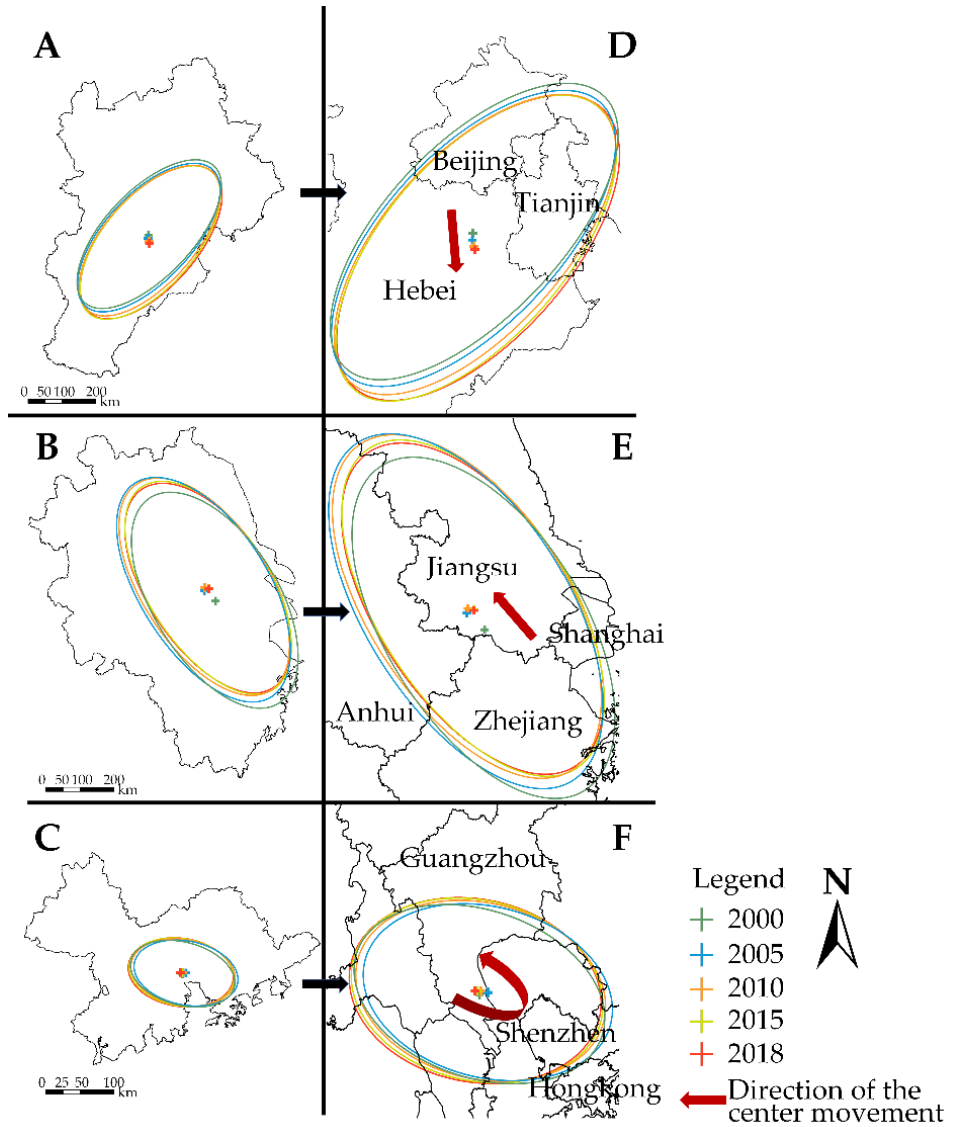
Figure 7. Results of the standard deviation ellipses of urban areas for three urban agglomerations from 2000 to 2018. ( A – C ) BTH, YRD, and GBA. ( D – F ) The locally enlarged ellipse for each image.